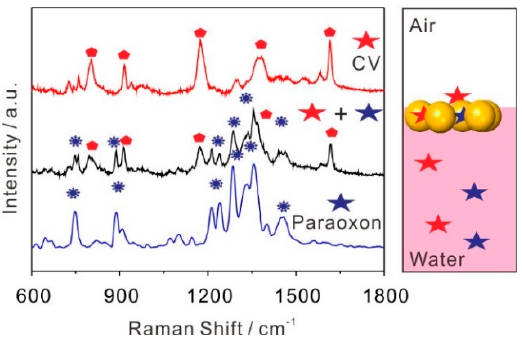
Figure 4. Self-assembly SERS platform for dual-analyte (black line) detection of 10 − 6 M paraoxon and 10 − 6 M CV in aqueous phase. SERS spectra of sole paraoxon (blue line) and CV (red line) in the aqueous phase, respectively, were measured as references.